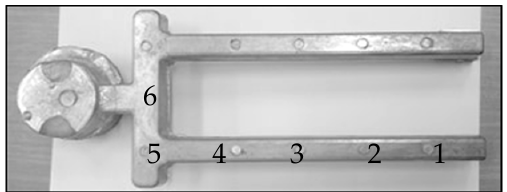
Figure 5 . Example of rheo-diecast bars, including biscuit and runner and showing the 6 positions for samples used for metallography and hardness measurements .